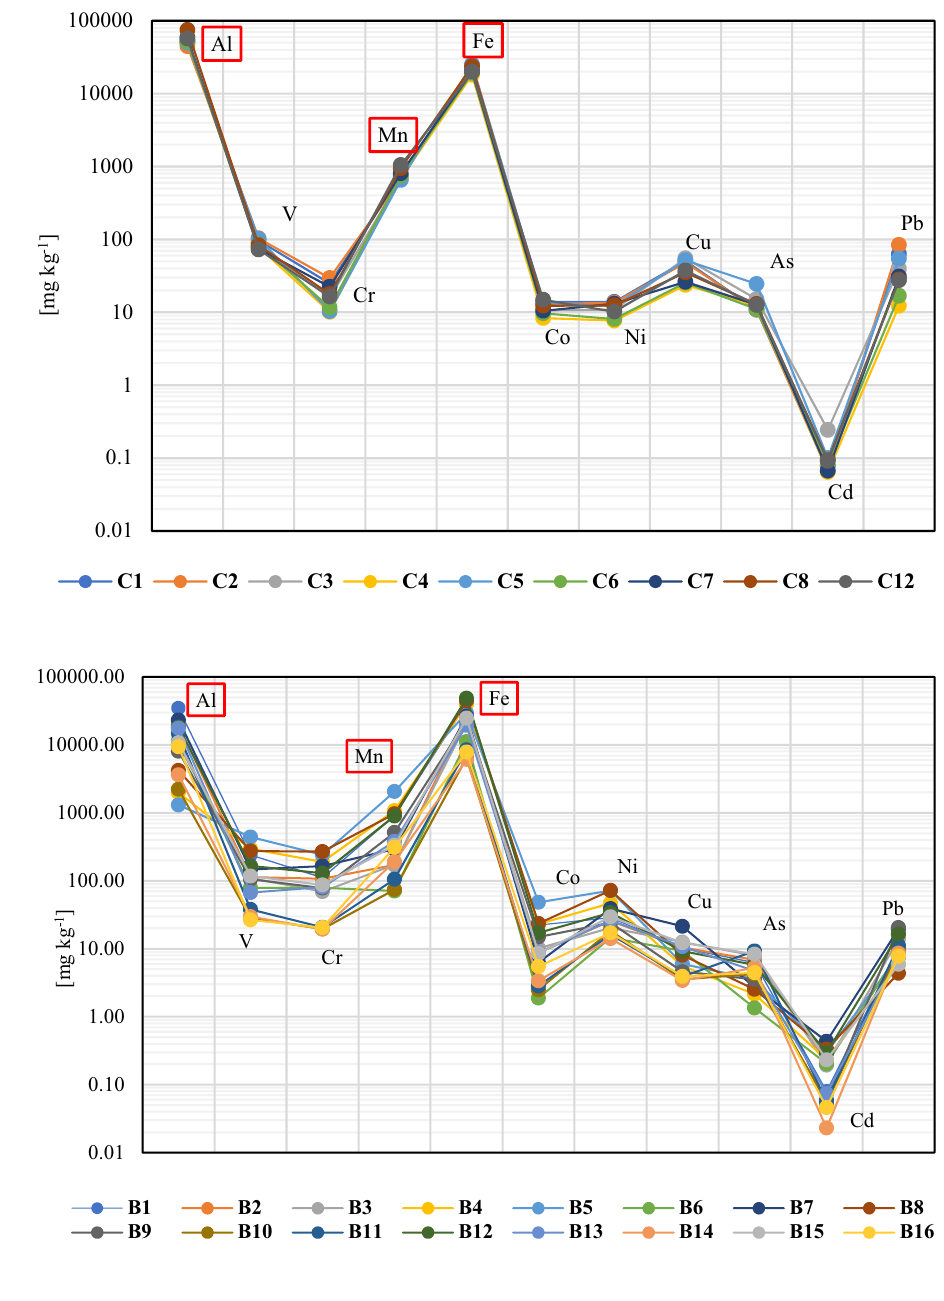
Fig. 5 Trend concentrations trace elements in the Appian Way Regional Park